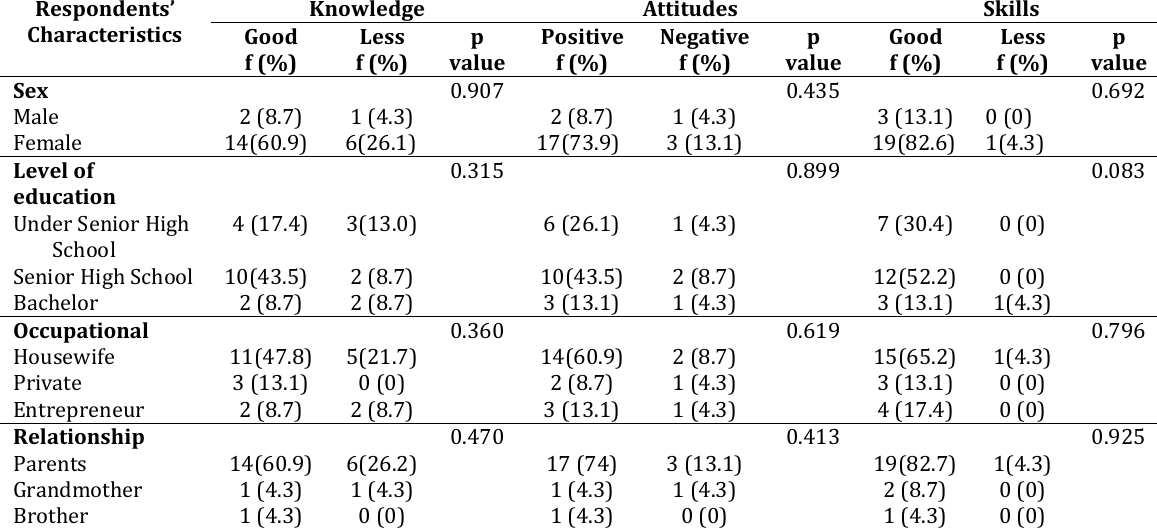
Skills Good >26.74 Table 3. Analysis of Chi Square Test Characteristics of Child Caregivers with Physical Disability with Knowledge, Attitude and Skills (n =